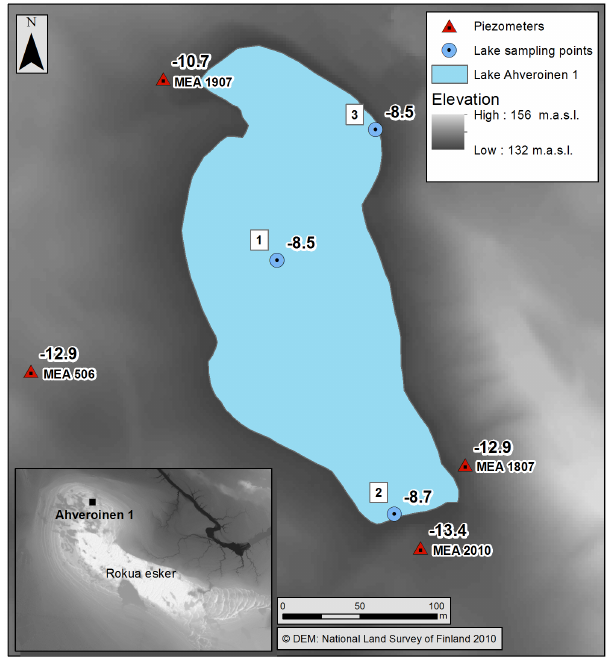
Figure 5. Mean δ 18 O values (‰) of lake Ahveroinen and adjacent groundwater. The mean δ 18 O value for site 1 is 8.5‰ at both sam- pled depths (1 and